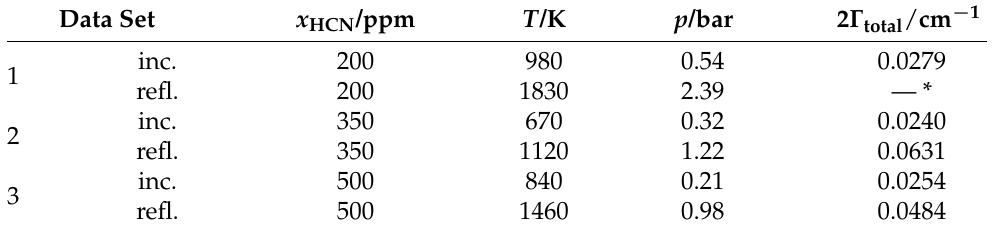
Table 1. Experimental conditions for FM line profile measurements behind incident (inc.)